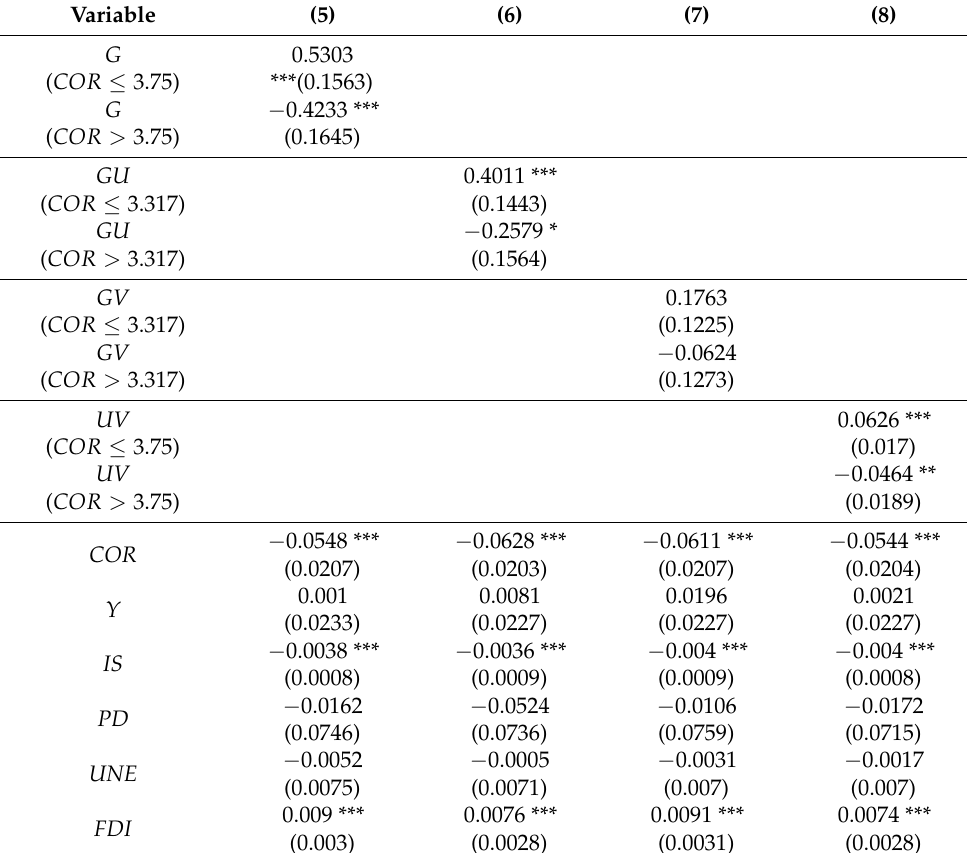
Table 4. Robustness test—alternative indicator of environmental